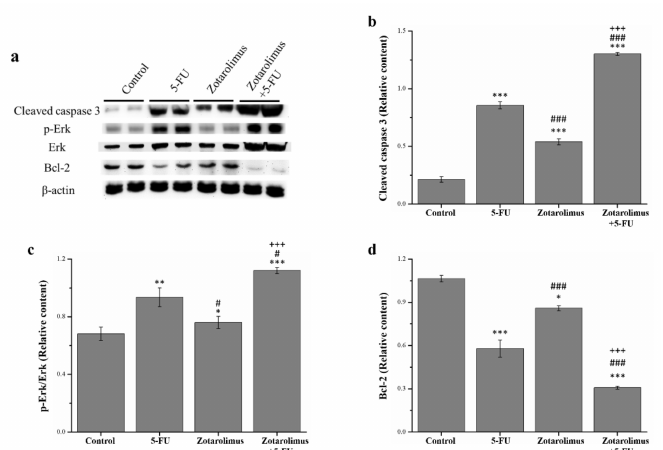
Figure 3. Analysis of apoptosis-related proteins including ( a ) representative Western blot showing the levels of apoptosis-related proteins extracted from the tumors; ( b ) cleaved caspase 3 expression; ( c ) ERK phosphorylation; and ( d ) Bcl-2 expression in the HCT-116 tumor masses taken from BALB/c nude control mice and mice administered different treatments: 5-FU (50 mg/kg/week), zotarolimus (2 mg/kg/day), and zotarolimus (2 mg/kg/day) combined with 5-FU (50 mg/kg/week). All data are presented as mean ± standard deviation, n = 8 per group. * p < 0.05, ** p < 0.01, and *** p < 0.001 compared with the control group. # p < 0.05 and ### p < 0.001 compared with the 5-FU-treated group. +++ p < 0.001 compared with the zotarolimus-treated